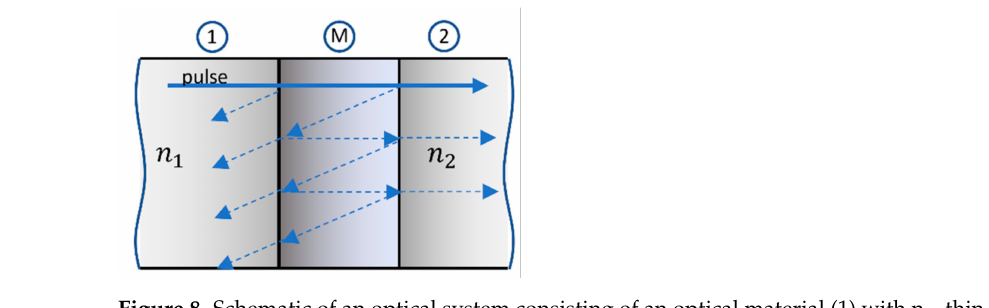
Figure 8. Schematic of an optical system consisting of an optical material (1) with n 1 , thin metal layer (M), and optical material (2) with n 2 .